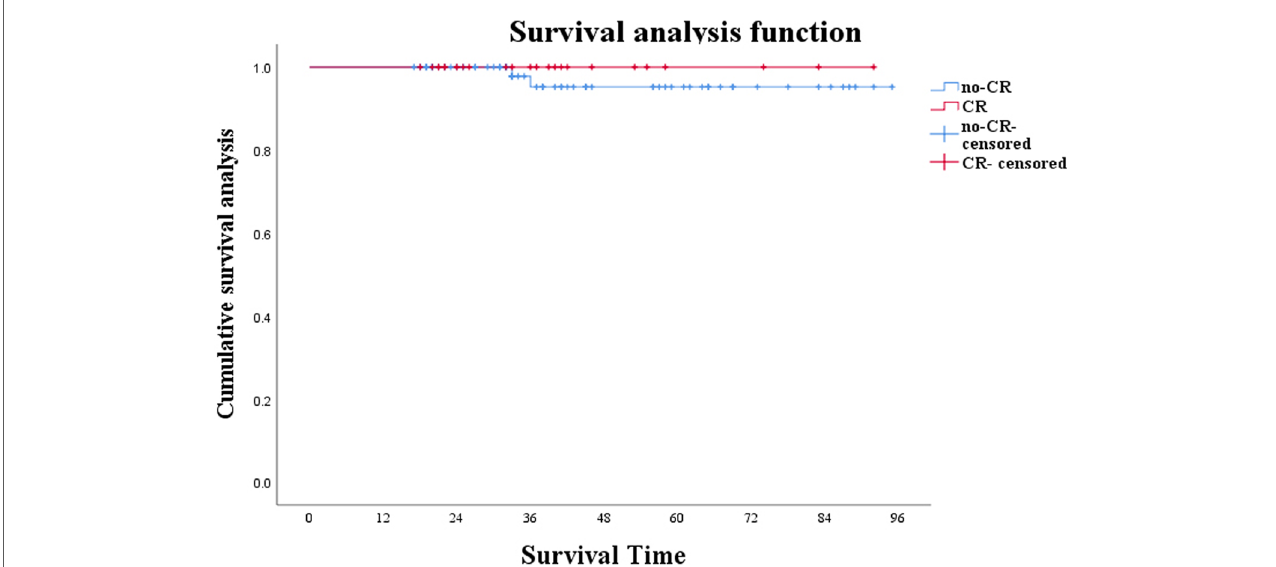
FIGURE 1 Survival analysis of patients under W&W follow-up strategy and those showing no cCR ( P =0.419).